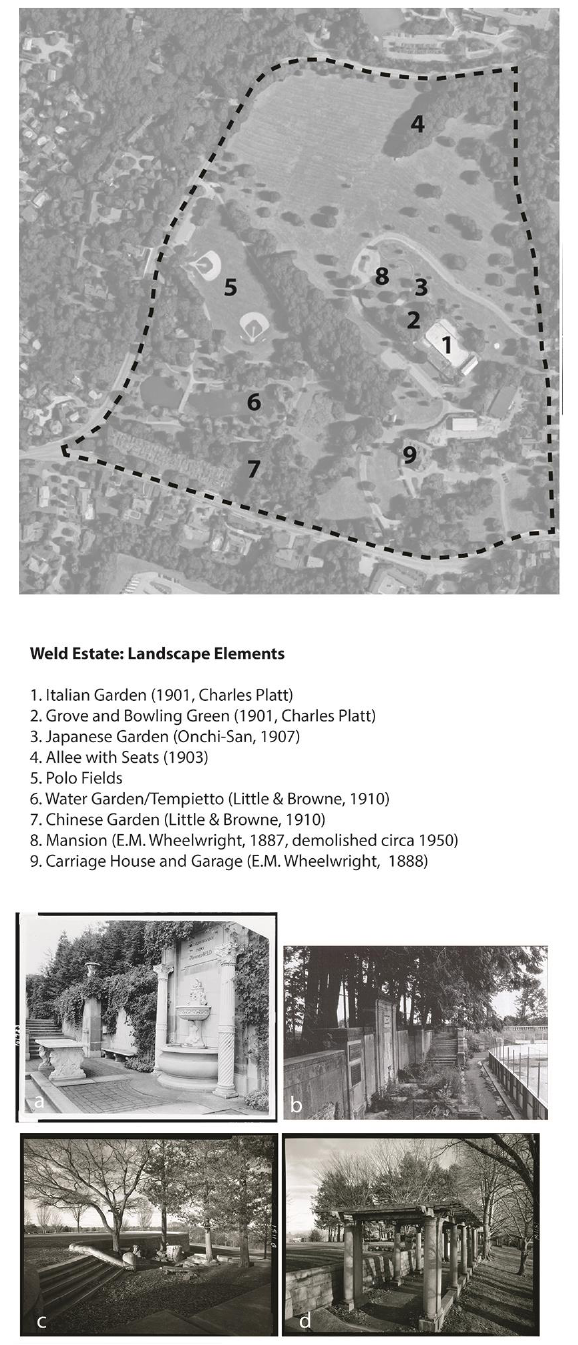
Figure 4. Key landscape features of the Weld Estate (now Larz Anderson Park). (a) Fountain at the Italian garden circa 1925 (b) Remnants of Italian garden behind ice skating rink in 2004 (c) Remnants of the Japanese garden in 2016 (d) Bowling green near footprint of the main house in 2015. Image credits: Google maps, Library of Congress, Evan Ide, Andrew